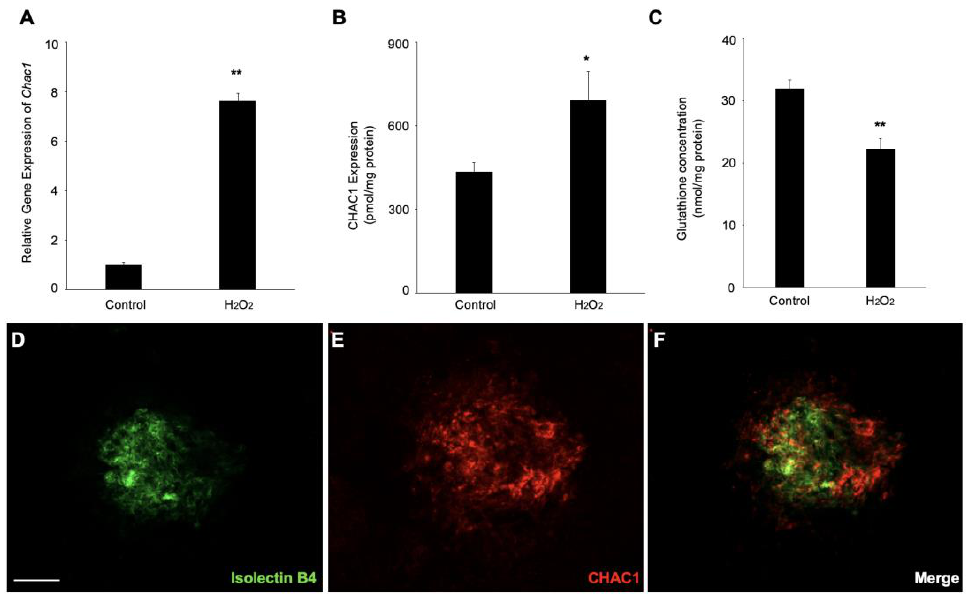
Figure 5. Gene and protein expression levels of Chac1 in ARPE-19 cells with hydrogen-peroxide stimulation. ( A ) Real-time PCR analysis for Chac1 . ( B ) CHAC1 protein levels in ARPE-19 cells with hydrogen peroxide stimulation. ( C ) GSH assay. ( D – F ) Double labeling of CHAC1 (red) and isolectin B4 (green) in CNV mice at day 7 . Scale bar = 100 μm. n = 6 in each group. * p < 0.05, ** p < 0.01.